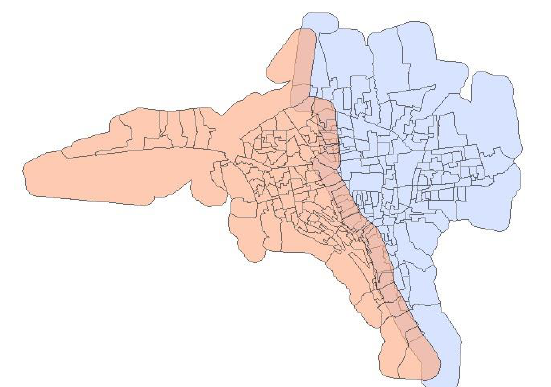
Figure 5. The map of census districts of Gorgan produced by